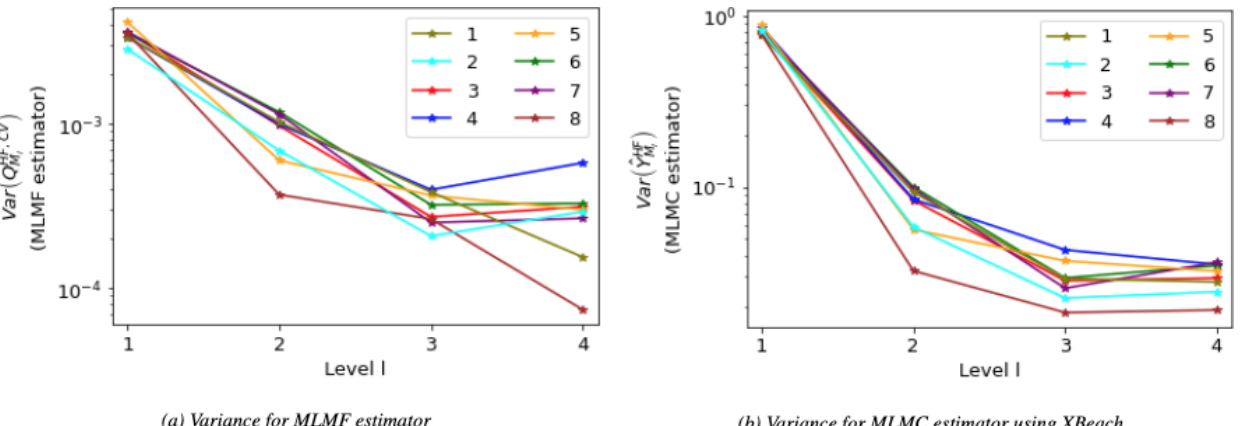
Figure 27. Comparing the different rates at which variance of the MLMF estimator (Eq. 6) and variance of the MLMC estimator for XBeach (Eq. B5) decrease as the resolution becomes finer. The x axis indicates the finest level considered by the MLMC and MLMF estimator. Note that the MLMF variance is 2 orders of magnitude smaller than the MLMC